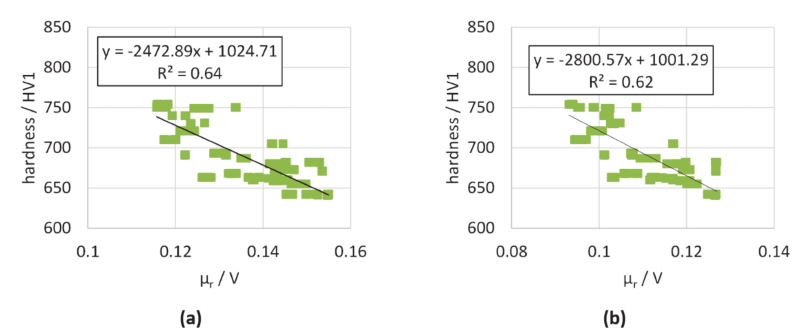
Figure 9. Correlation between hardness and amplitude at the remanence point of the incremental permeability µ r measured with a base magnetization frequency of 120 Hz and an eddy current loop frequency of 100 kHz ( a ) and a base magnetization frequency of 150 Hz and an eddy current loop frequency of 250 kHz ( b